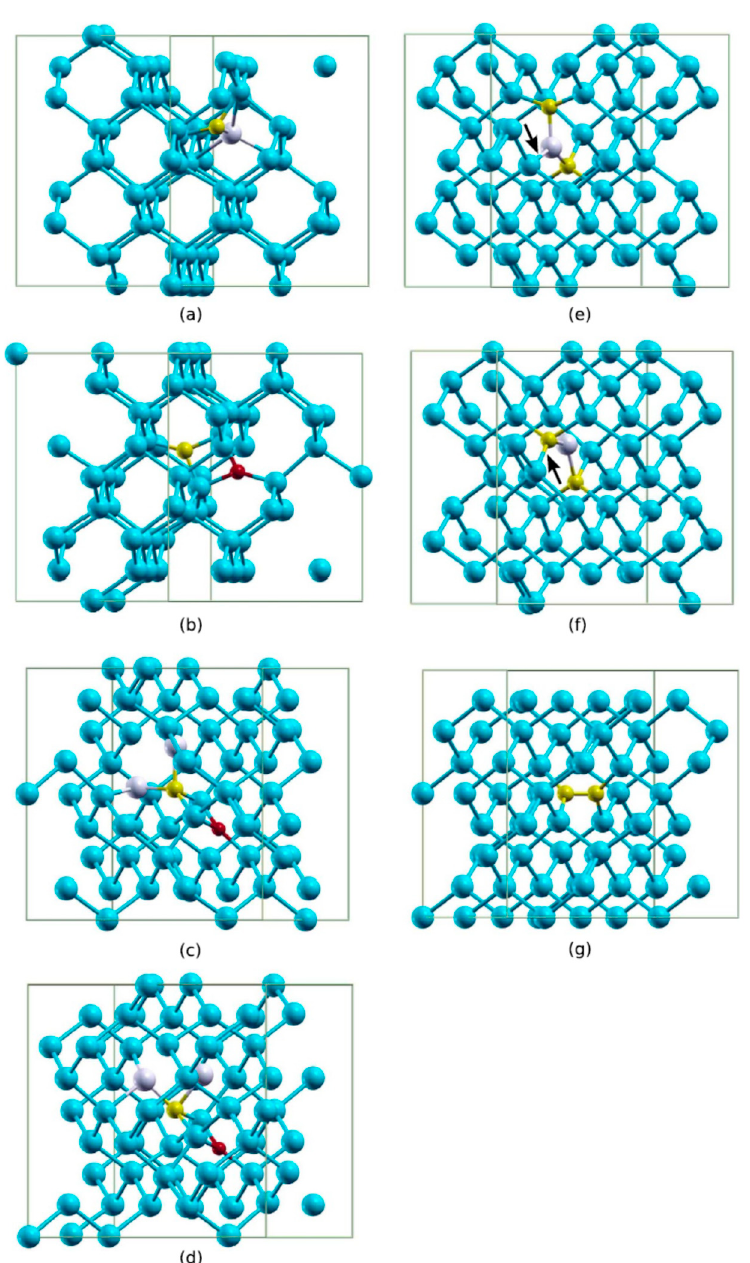
Figure 27. DFT-derived minimum energy structures for carbon related defects: ( a ) C i (Si I ), ( b ) C i O i , represent the Si atoms, yellow spheres represent the C atoms, and red spheres represent the O atoms Reproduced with permission from [22].